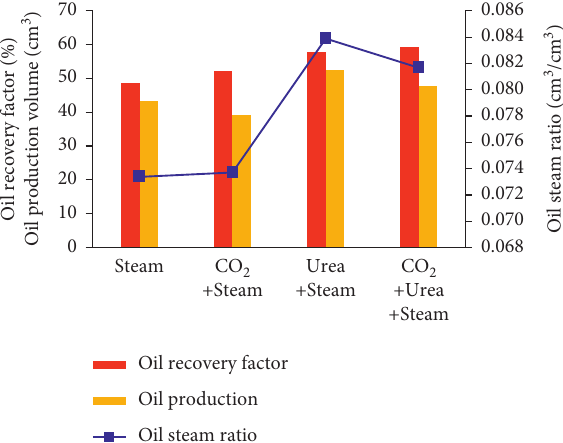
Figure 4: Comparison of production performance with different medium-assisted steam flooding processes.